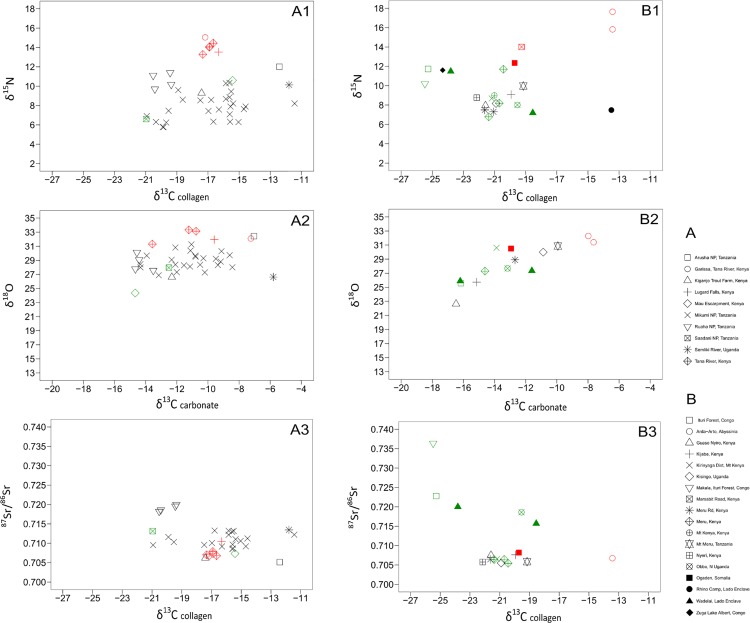
δ13C, δ15N, δ18O and 87Sr/86Sr values for modern and historic provenanced elephant samples from East Africa.(A1-3) Three plots of modern (post-1950) elephant tissue samples collected from museum specimens and national parks in Tanzania (see S1 Table). Colours of all samples correspond to habitat following [41] for East African elephant habitats: green is forest/mountain, black is savanna mosaic (incorporates a wide range of woodland/bushland/grassland habitats) and red is arid (incorporates arid bushland and grassland habitats), with habitat descriptions following [97]. (A1) δ13C and δ15N values of collagen, (A2) δ13C and δ18O values of carbonate, and (A3) δ13C and 87Sr/86Sr values, from collagen and carbonate respectively. (B1-3) Three plots of historic (1896–1909) elephant tissue samples collected from museum specimens (see S1 Table). (B1) δ13C and δ15N values of collagen, (B2) δ13C and δ18O values of carbonate, and (B3) δ13C and 87Sr/86Sr values, from collagen and carbonate respectively.